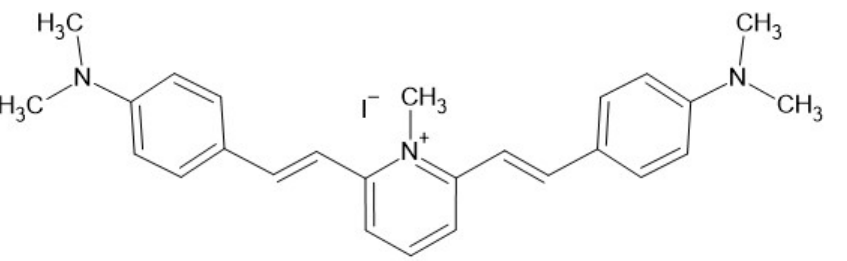
Figure 1. Chemical structure of PB4, the figure was created using BioRender bioinformatic tool. PB4 activity was evaluated on selected samples of MRSA, VRE, ESBL and CRAB freshly isolated from nosocomial infections. The workflow is shown in Figure 2.